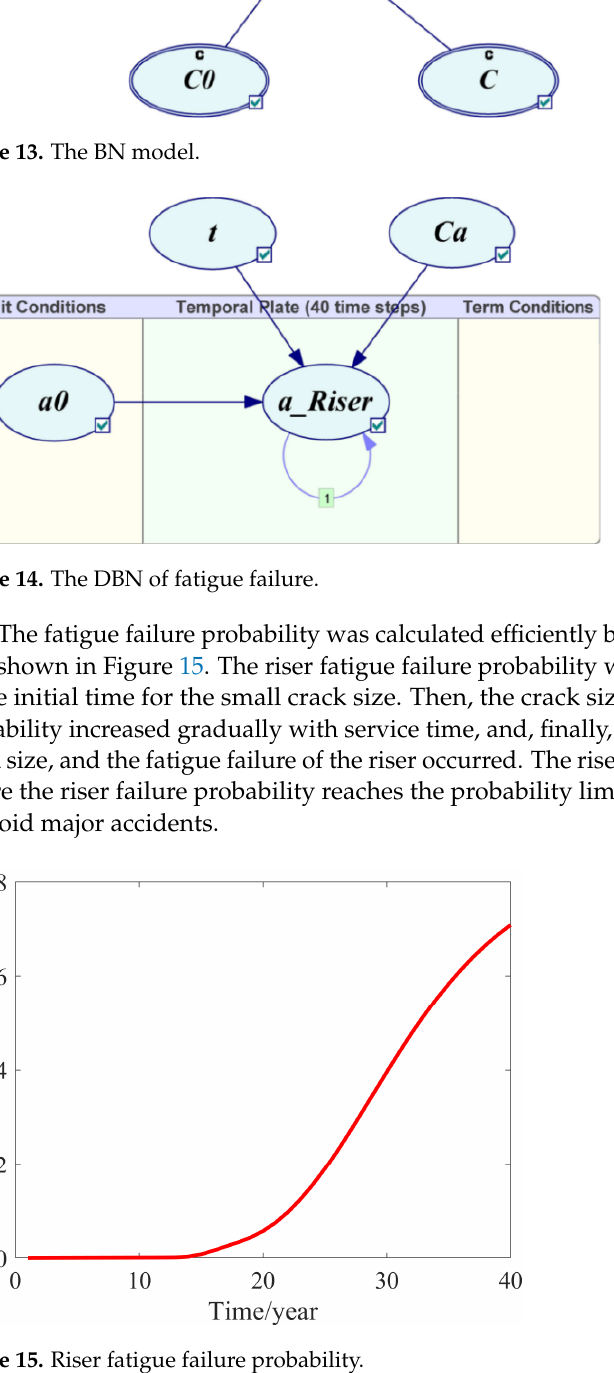
Figure 15. Riser fatigue failure probability.